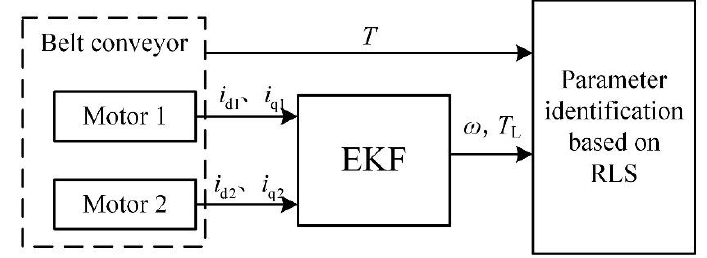
Figure 4. Parameter identification scheme based on EKF and RLS.